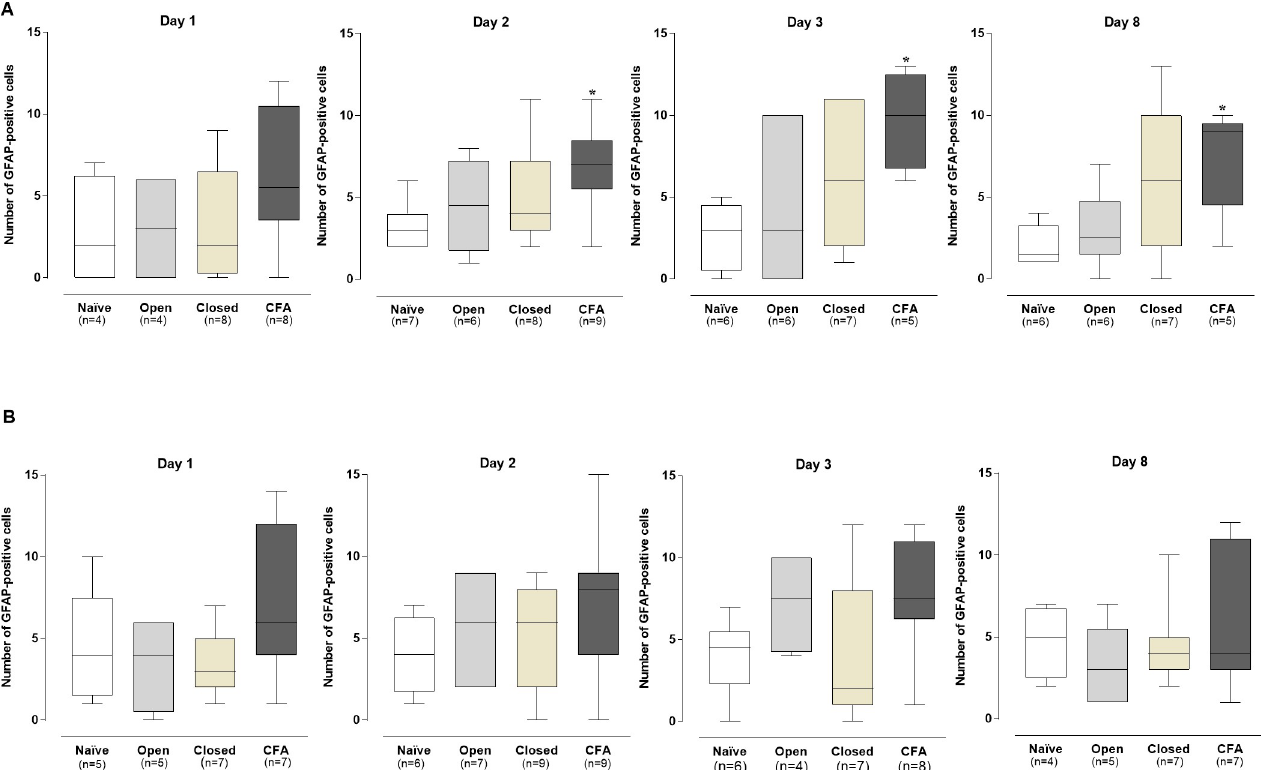
Fig 7. GFAP-immunopositive glial satellite cells in the ipsilateral (A) and contralateral (B) trigeminal ganglion in the different experimental groups. The box plots show the median of 4–7 experiments with the upper and lower quartiles. The whiskers indicate the maximal and the minimal values. � P < .05 (Kruskal-Wallis plus Dunn’s test).